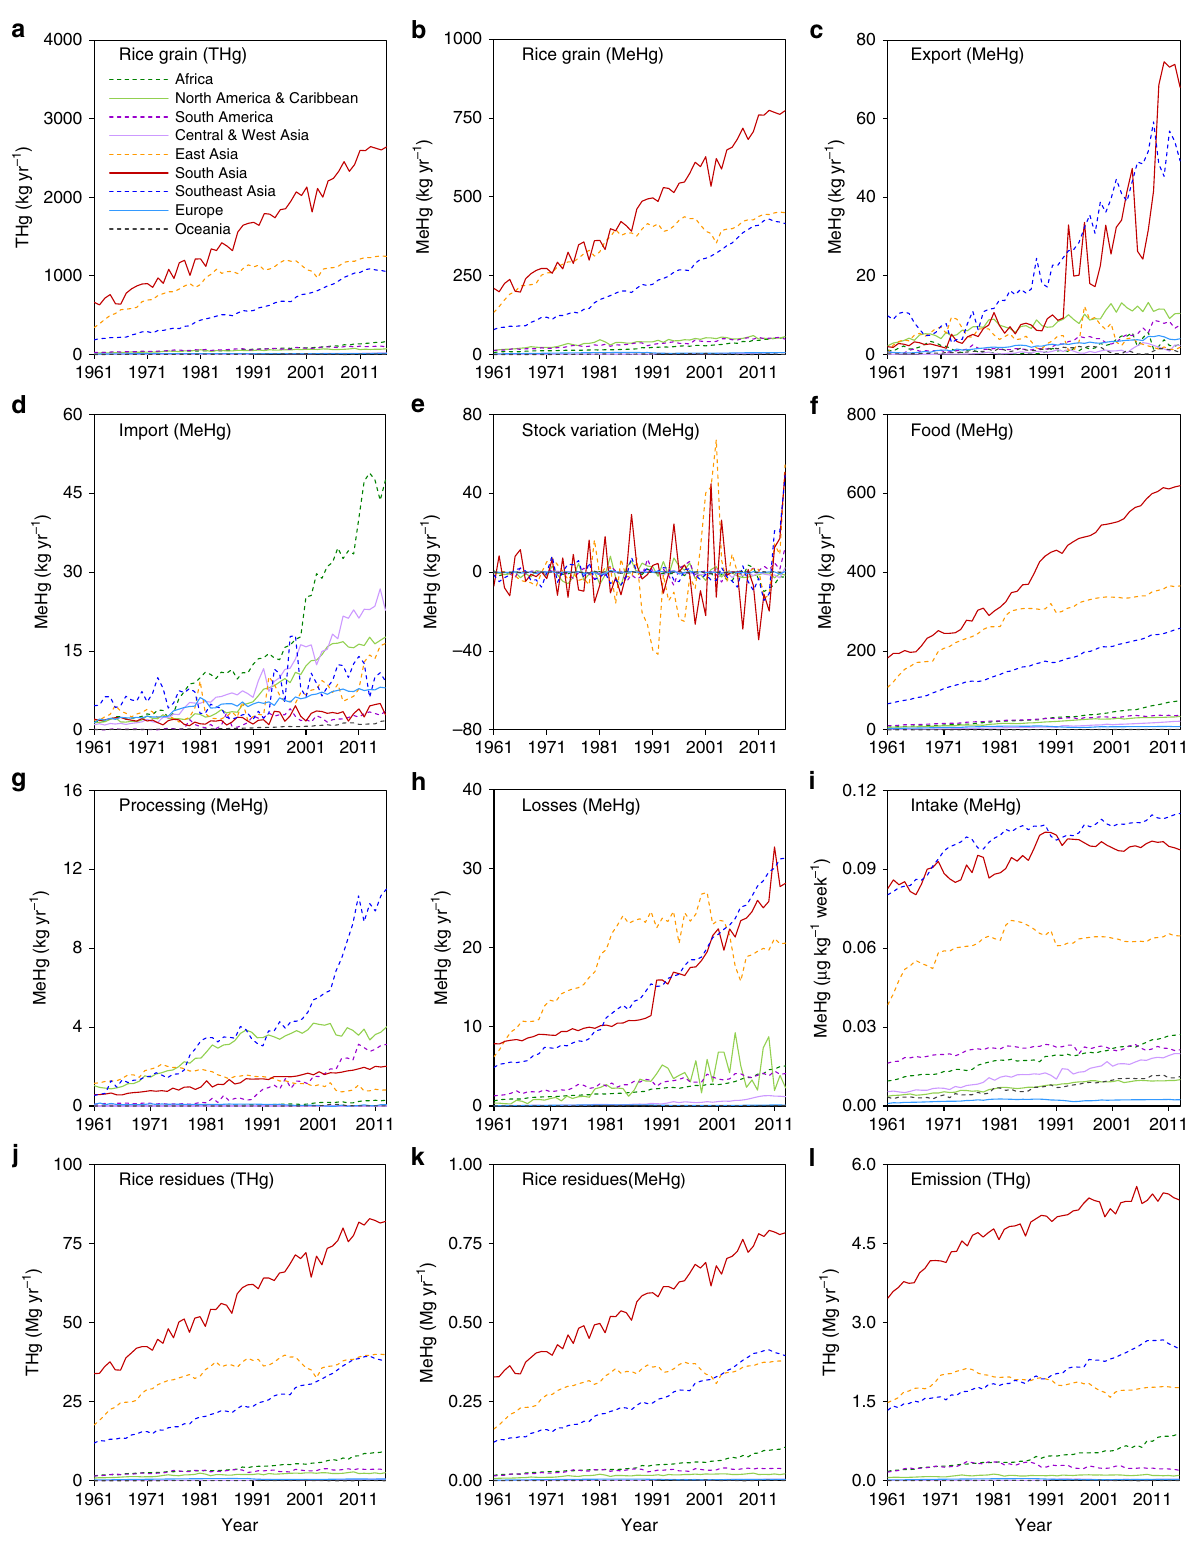
Fig. 2 Temporal trends of mercury generated during the rice life cycle. a , b Amounts of THg and MeHg generated in rice grain from 1961 to 2016; c , d amounts of MeHg transported by rice export and import, respectively, from 1961 to 2016; e stock variation of MeHg from 1961 to 2016; f amounts of MeHg supplied as food from 1961 to 2013; g amounts of MeHg related to processing from 1961 to 2013; h amounts of MeHg losses during transportation